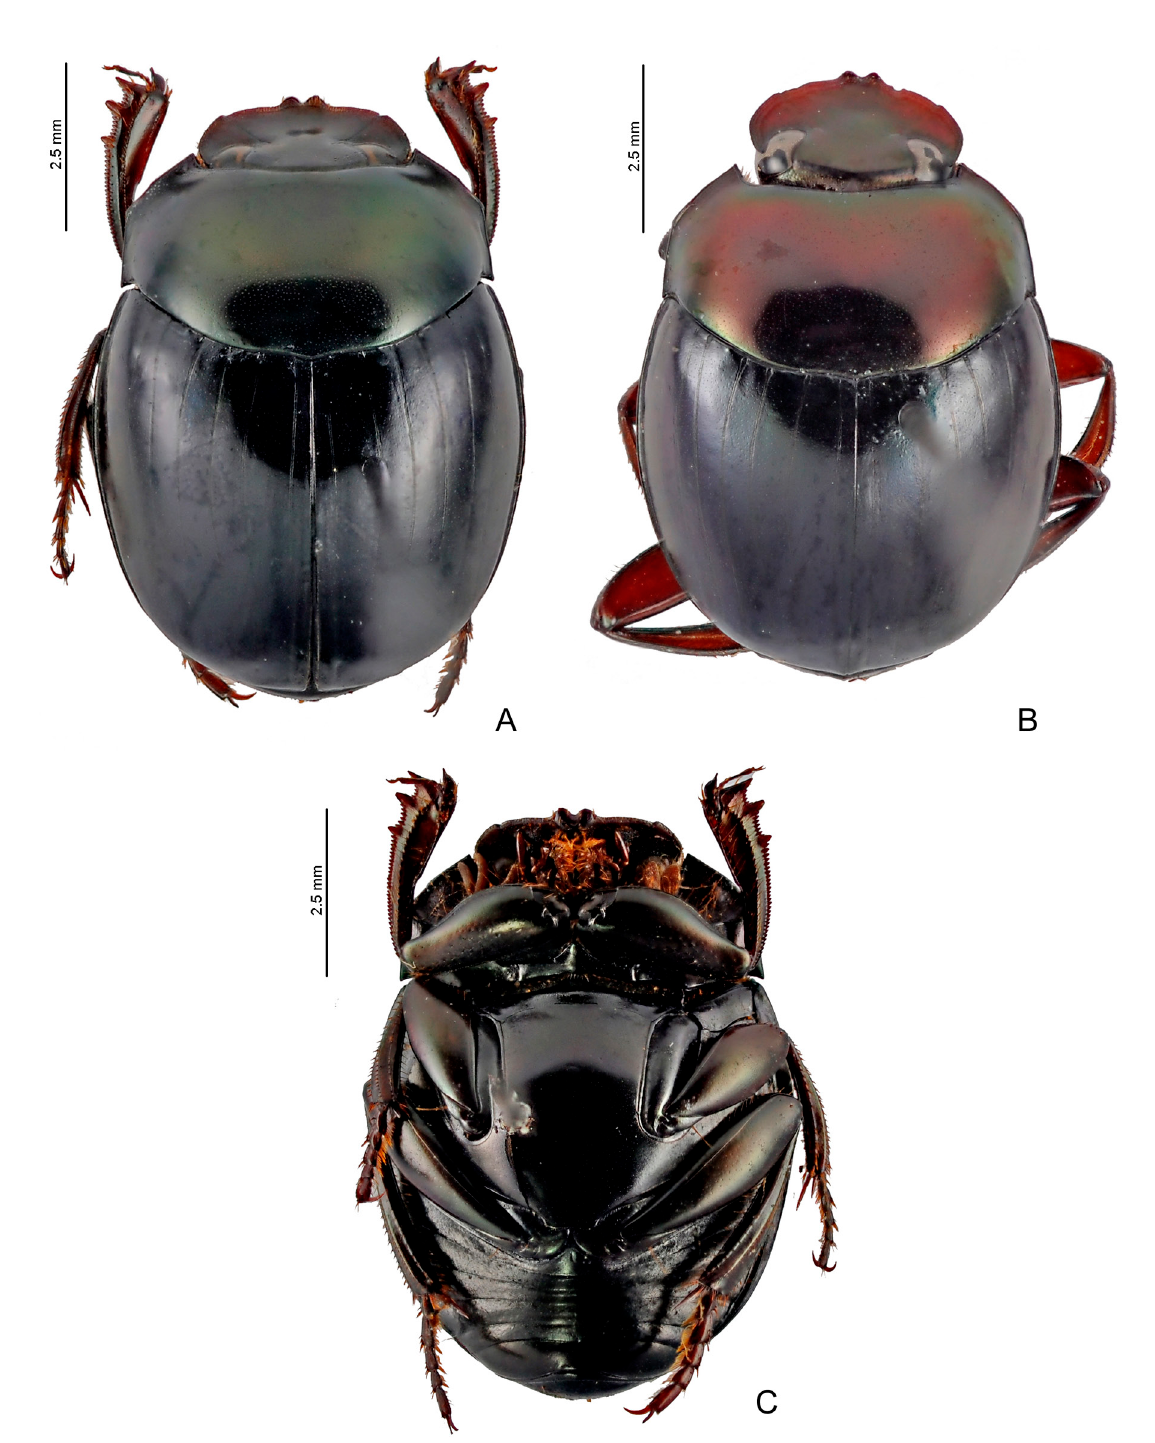
Fig. 42. Sylvicanthon obscurus (Schmidt, 1920). A . Dorsal view of the purplish form. B . Dorsal view of the yellowish form. C .